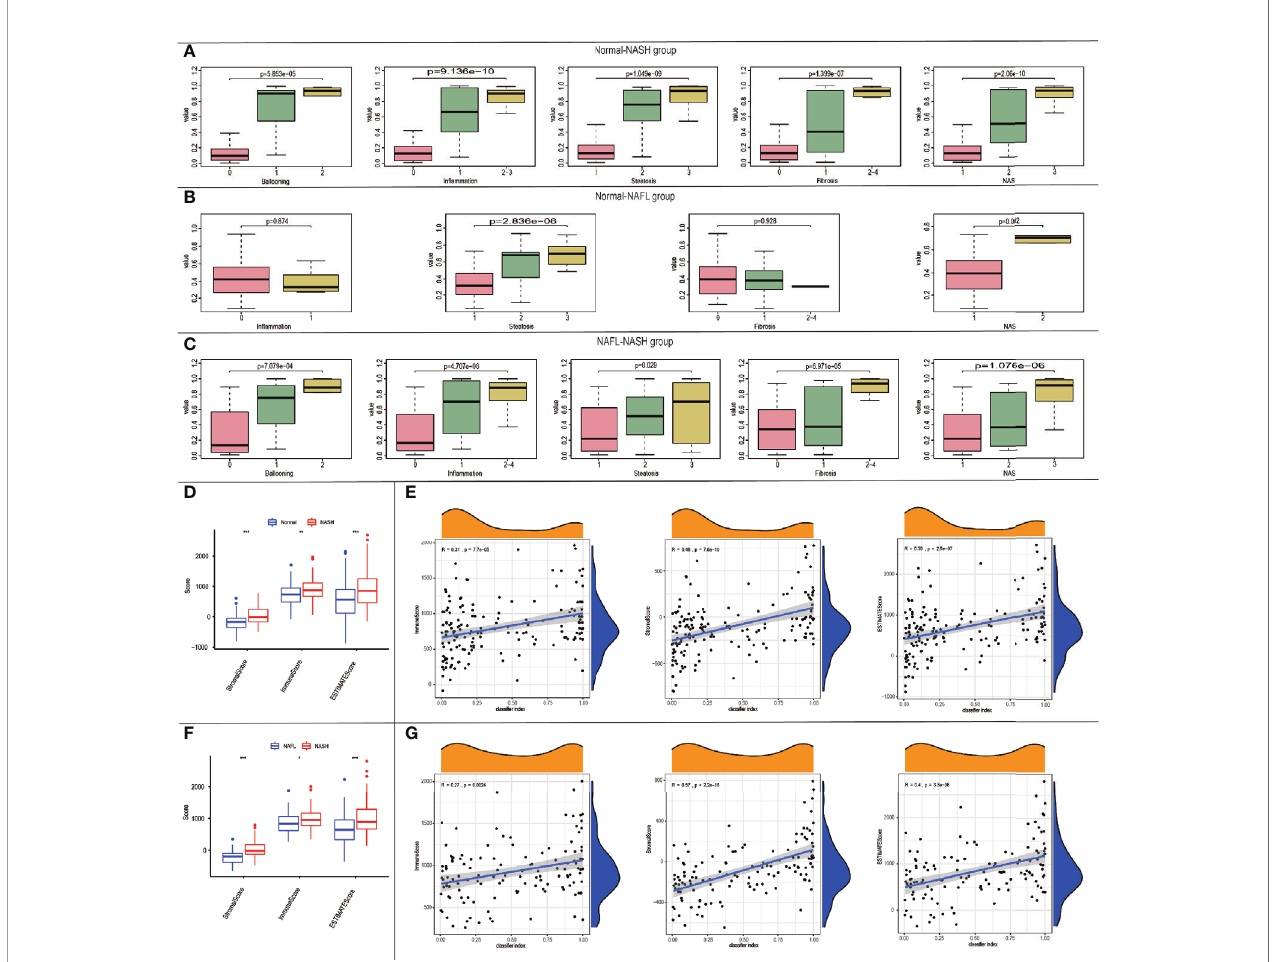
FIGURE 6 | The relationship between the classi fi er index and clinical characteristics. (A-C) Boxplots of the relationship between classi fi er index and clinical characteristics in Normal-NASH group (A) , Normal-NAFL group (B) , NAFL-NASH group (C) ; (D) Boxplot of the relationship between classi fi er scores and immune microenvironment scores in Normal-NASH group; (E) Diagram validating correlation between classi fi er scores and immune microenvironment scores in Normal- NASH group; (F) Boxplot of the relationship between classi fi er scores and immune microenvironment scores in NAFL-NASH group; (G) Diagram validating correlation between classi fi er scores and immune microenvironment scores in NAFL-NASH